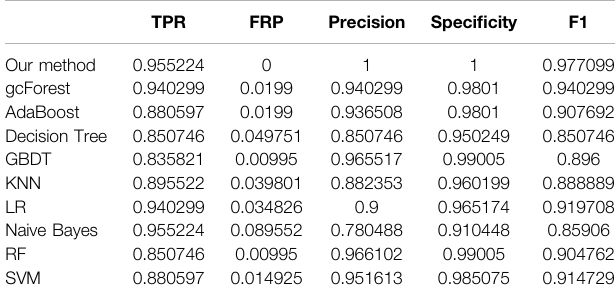
TABLE 3 | Classi fi cation performances of ten methods with 6-cross validation methods. TPR FRP Precision Speci fi city F1